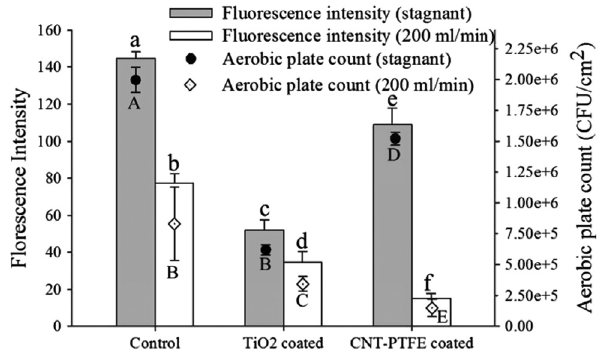
Figure 19: Fluorescence intensities and aerobic plate counts. The signi fi cant di ff erences corresponding to fl uorescence intensity and aerobic plate count measurements are indicated by lower and uppercase letters [ 124 ] . Reproduced with permission from ref. [ 124 ] ; © 2013 Elsevier